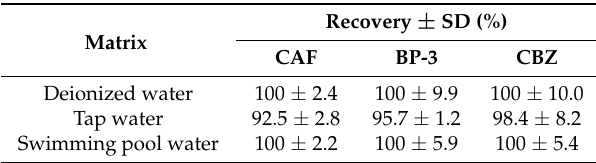
Table 6. Recoveries obtained in the most optimal solid phase extraction methodology (methanol + acetonitrile and ENVI-18 tube) for different matrices.